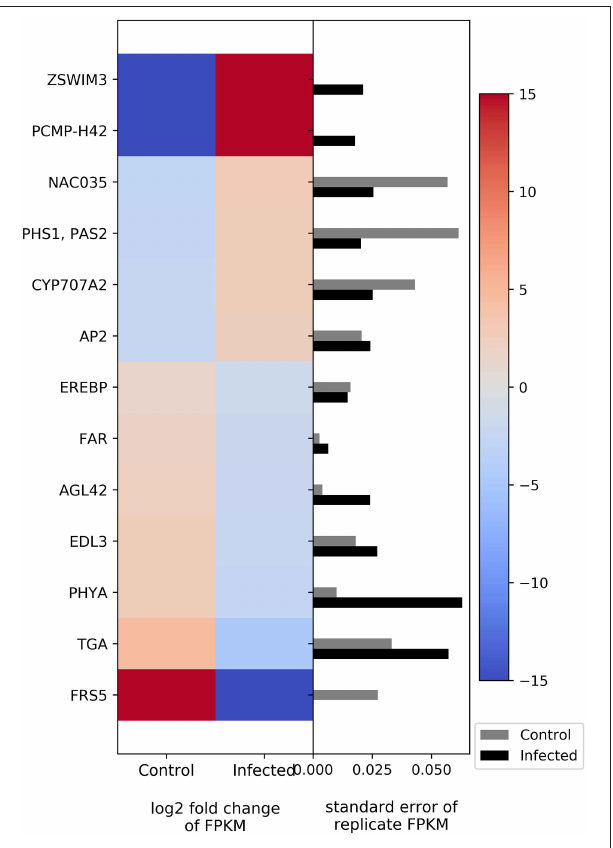
FIGURE 5 | Heatmap of DEGs related to flowering and development. The left side of the plot is the heatmap of log2 fold change of FPKM between all infected and uninfected groups. The right side of the plot is the standard error for all replicates divided by the average FPKM for the uninfected and infected groups. See Supplemental Table 2 for gene names associated with all